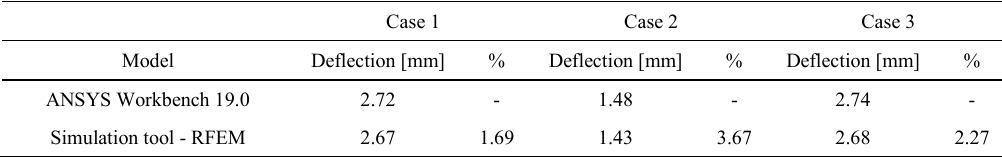
Table 4: Maximum deflection on the inner pane. Cylindrical model.